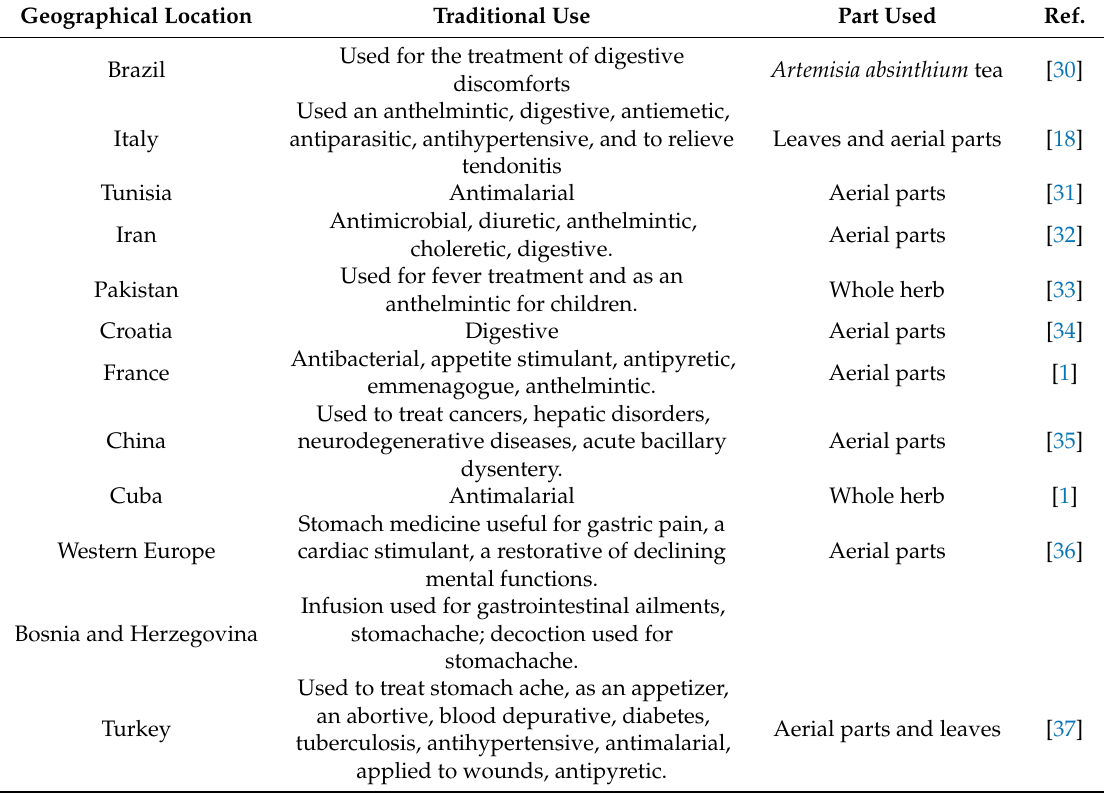
Table 3. Traditional uses of A. absinthium